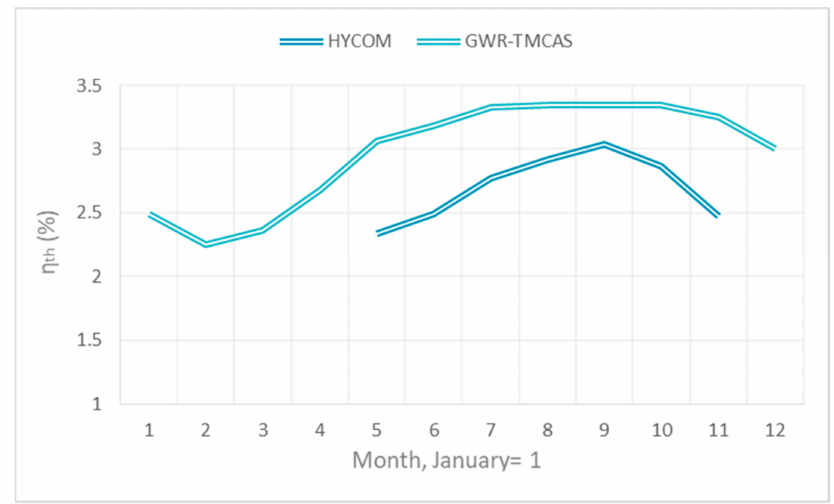
Figure 7. Thermal efficiency along the year for OTEC-CC-MX-1 kWe obtained using HYCOM and GWR-TMCAS temperature data.